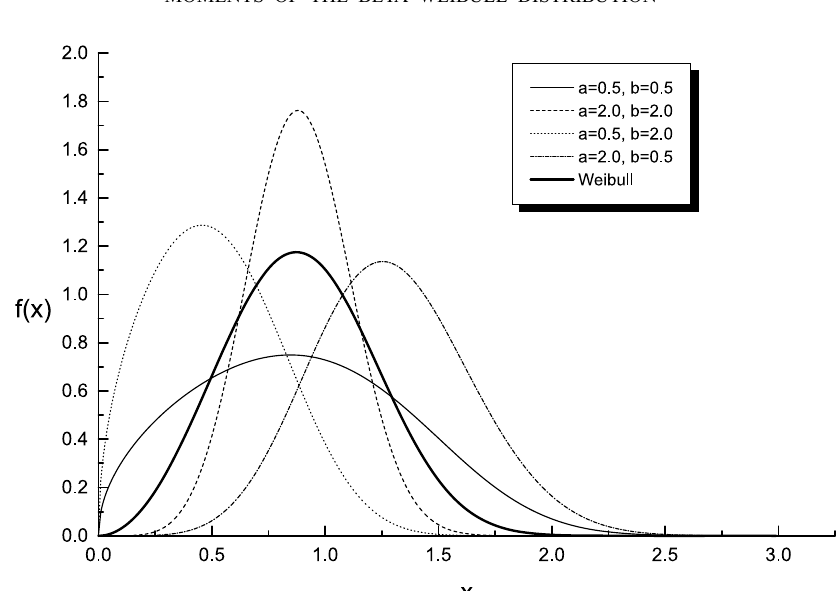
Fig. 1 – The BW density function (3) for selected values of parameters a and b .